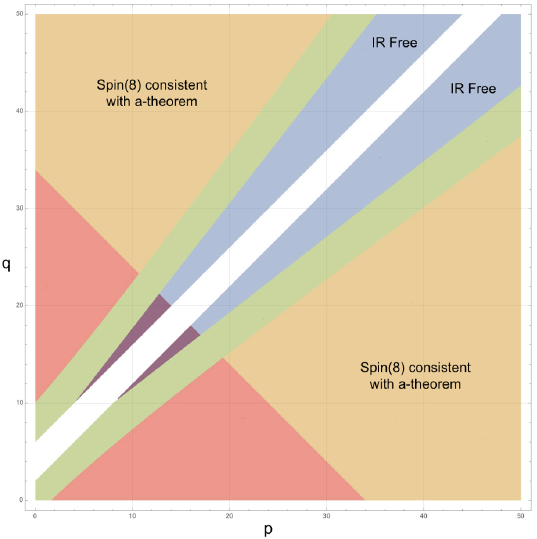
Figure 4 . Candidate low energy phases of the chiral SU( N ) theories, plotted as a function of q and p . The upper region is the chiral theory with a symmetric fermion and the lower with an anti-symmetric fermion. In the white strip, there are no chiral theories carrying a representation of the global symmetry group G . In the blue strip, the SU( N ) chiral theory is IR free. The green region is where flows to the Spin(8) theory are inconsistent and form a potential conformal window for the chiral gauge theory. The orange and light red regions are where the flow from the chiral theories to the Spin(8) theory is consistent with the a -theorem; in the orange region the Spin(8) theory is IR free and in the light red region it is asymptotically free. Finally, the dark red region shows where a flow from Spin(8) to the infra-red free chiral theory is